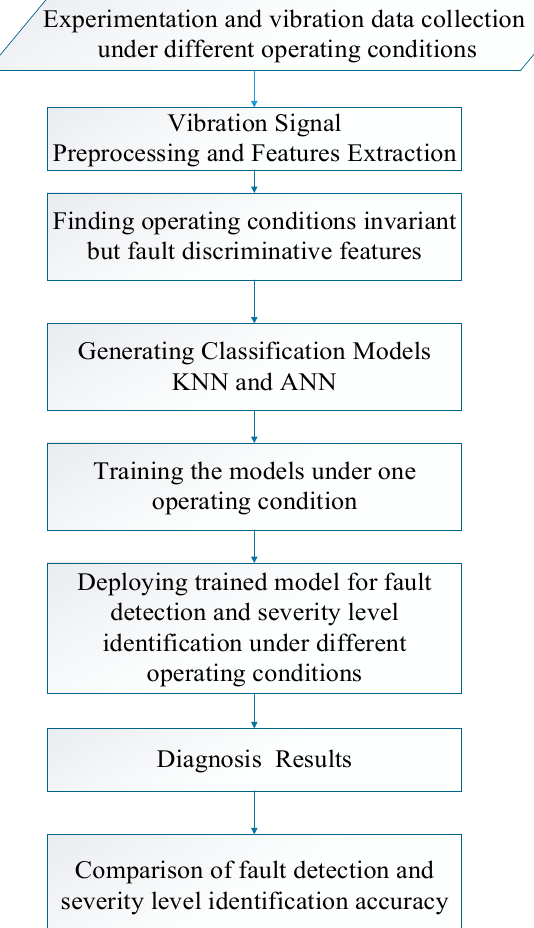
Figure 2. Methodology flow chart.